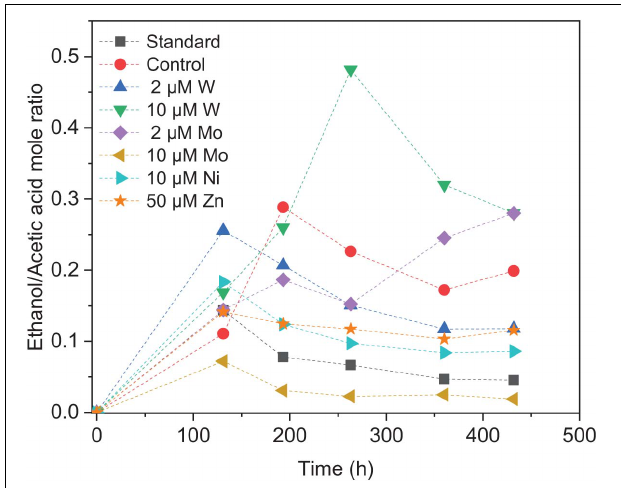
FIGURE 5 | Ethanol to acetic acid mole ratio by heat-treated granular sludge using H 2 /CO 2 as the substrate at 25 ◦ C with the standard medium, control and addition of 2 µ M, 10 µ M W, 2 µ M, 10 µ M Mo, 10 µ M Ni, and 50 µ M